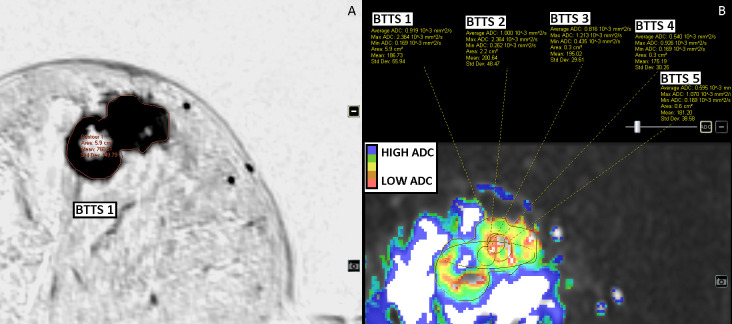
Invasive ductal carcinoma of the right breast, ER and PR positive, HER2-neu negative.DCE-T1 subtracted images (inverted) (A) and DWI b0-1000 images (B).